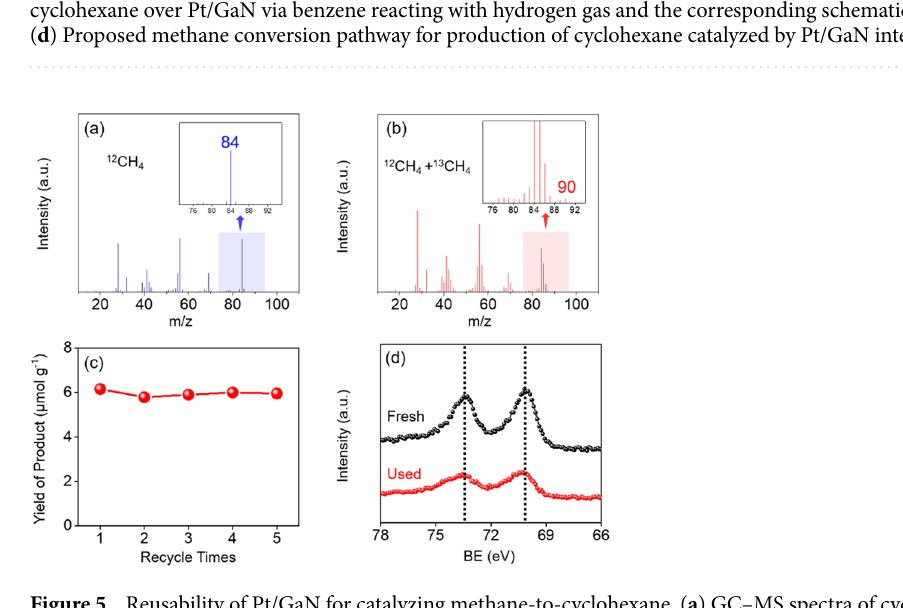
Figure 5. Reusability of Pt/GaN for catalyzing methane-to-cyclohexane. ( a ) GC–MS spectra of cyclohexane derived from 12 CH 4 and ( b ) the mixture of 12 CH 4 and 13 CH 4 . ( c ) Yield of cyclohexane over reused Pt/GaN. Reaction conditions: 2 mmol of methane, 20 mg of catalyst, 300 °C, 2 h. ( d ) Pt 4f XPS spectra of fresh and used